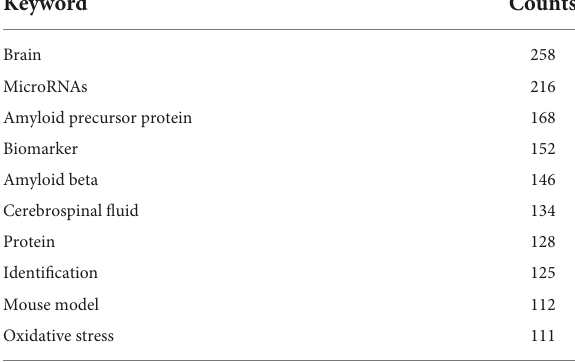
TABLE 6 Top 10 co-occurrence keywords via CiteSpace.